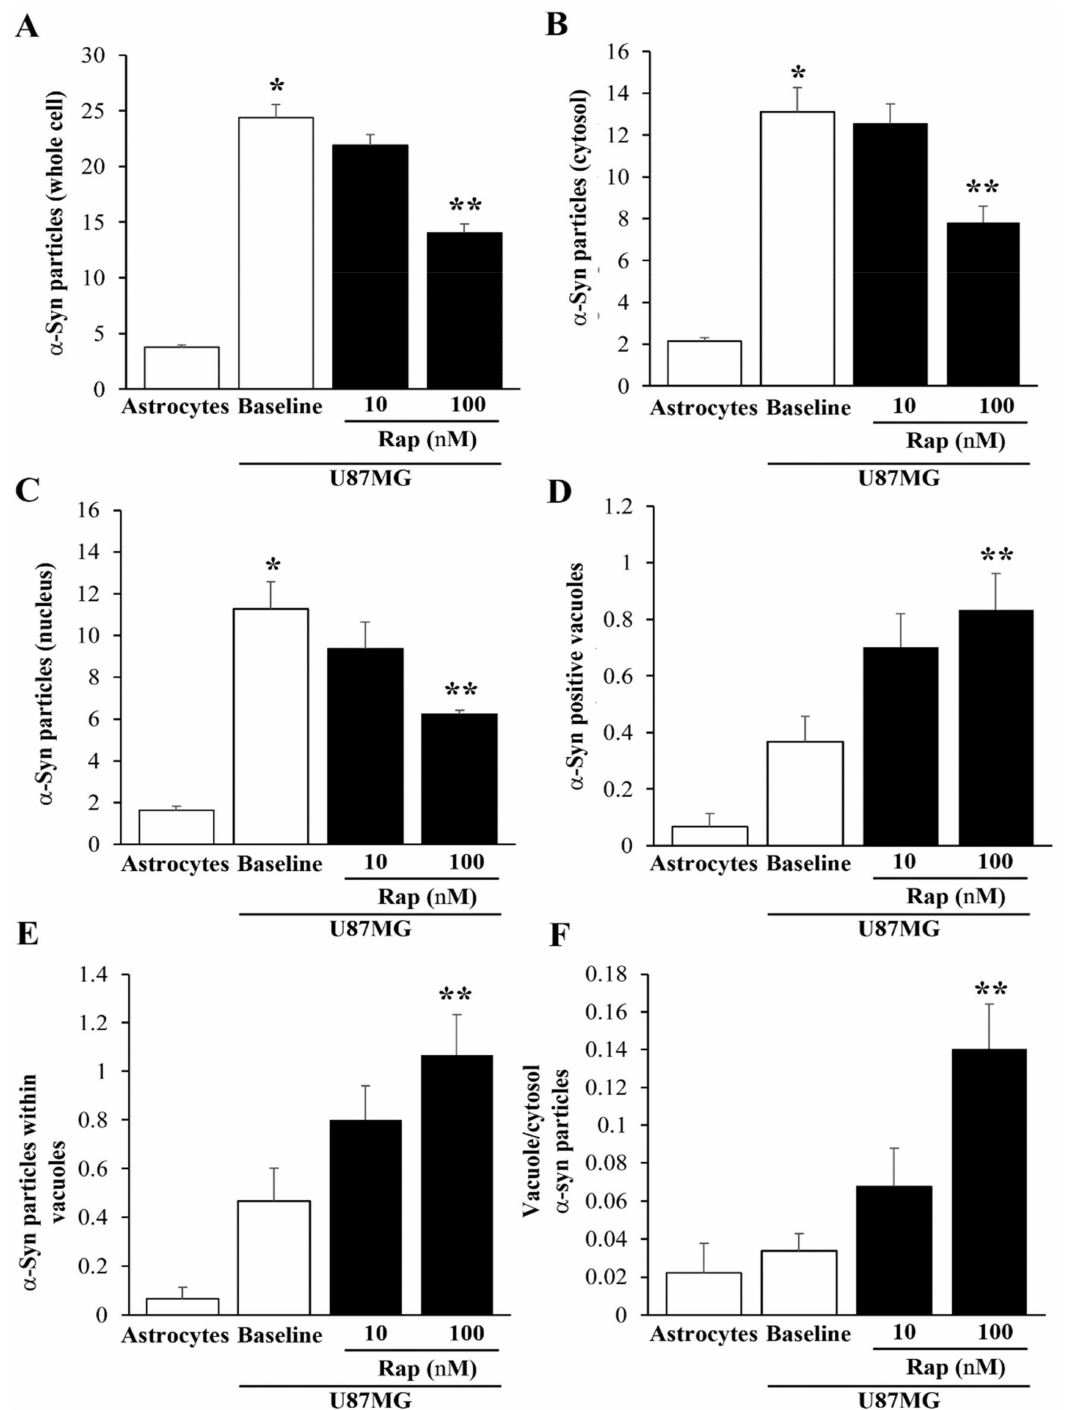
Figure 17. Count of PK-resistant α -syn immuno-gold within astrocytes and U87MG cells. Graphs report the number of α -syn immuno-gold particles within the whole cell ( A ), cytosol ( B ), and nucleus ( C ). The number of α -syn-positive vacuoles is reported in ( D ), while the mean number of α -syn immuno-gold particles within each vacuole is reported in ( E ). The ratio of α -syn immuno-gold particles within vacuoles vs. the cytosol is reported in ( F ). These data were obtained from astrocytes and U87MG after PK treatment in baseline conditions and following rapamycin exposure (Rap 10 nM and Rap 100 nM). Data are given as the mean ± SEM from n = 30 cells per experimental group, obtained from N = 3 independent experiments. * p < 0.05 compared with astrocytes; ** p < 0.05 compared with